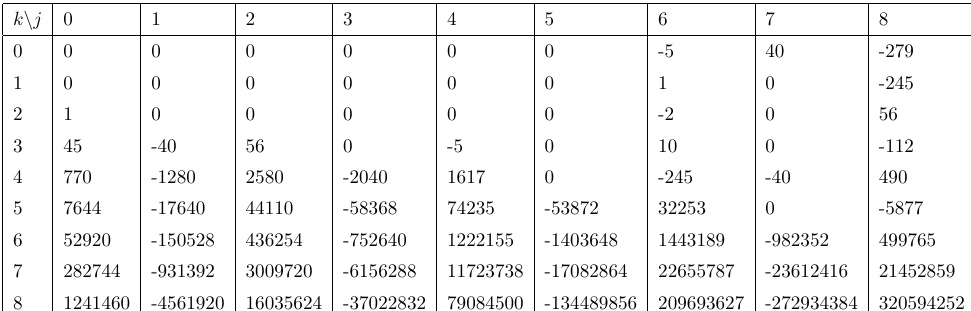
Table 75. Table of b jk coe(cid:14)cients for h SO(10)